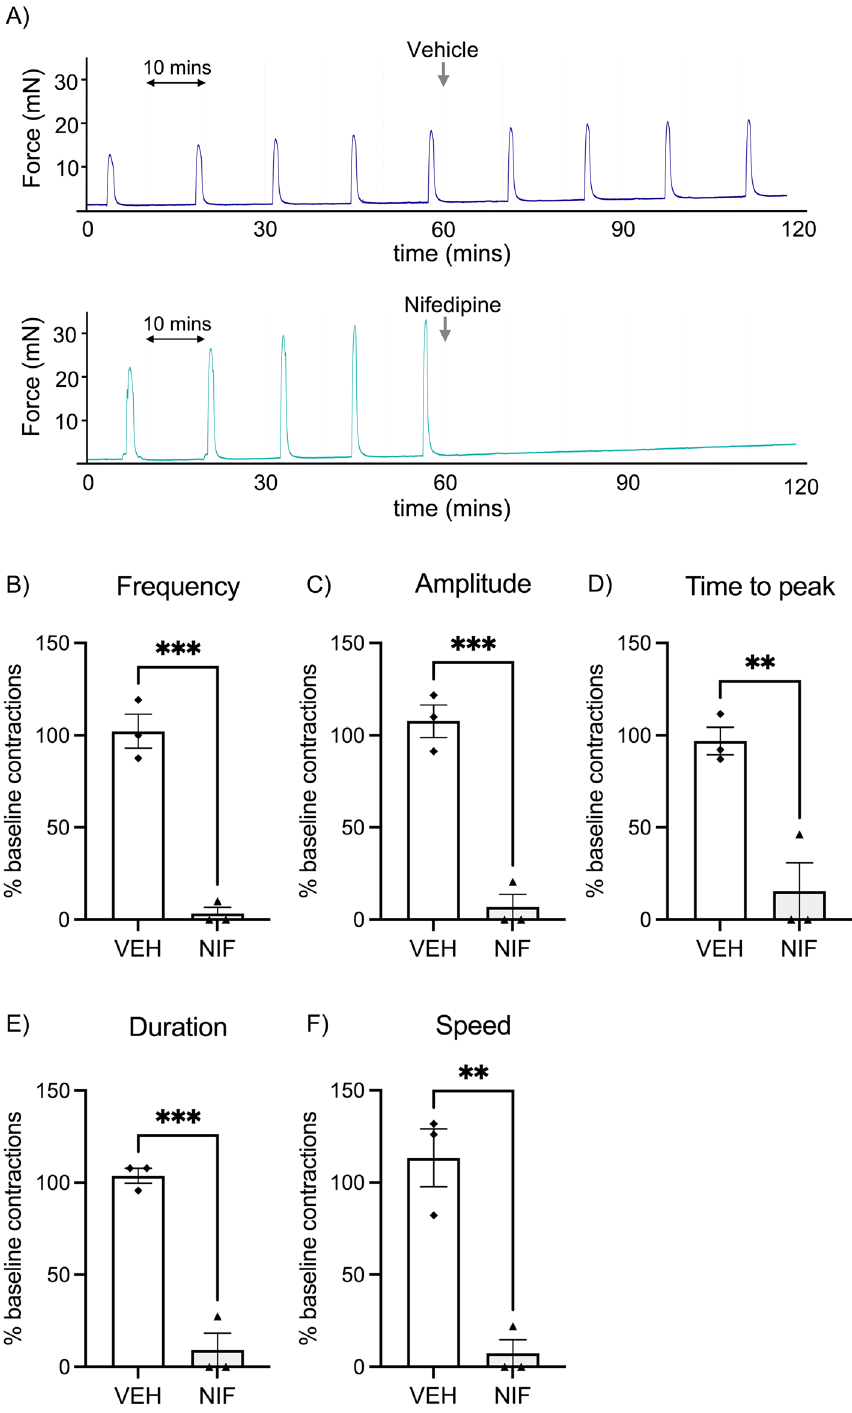
Figure 1. Myograph data showing anti-contractile effects of nifedipine (0.1 µM) on strips of human pregnant non-labouring myometrium ex vivo. ( A ) Representative trace in the upper panel showing that vehicle control (VEH) has no effect on established spontaneous contractions. In the lower panel, nifedipine (NIF) diminishes the established pre-treatment contractions. The y-axis is the measured force (millinewtons; mN). The entire initial 120 min equilibration period is not shown in these representative traces. ( B–F ) Nifedipine significantly reduces contraction frequency ( B ), amplitude ( C ), time to peak ( D ), contraction duration ( E ), and contraction speed ( F ) ( n = 3 patients). Data are presented as percentage of baseline (pre-treatment) contractility. Each point represents the mean of duplicates. Data were assessed for statistical differences using t tests. The error bars represent SEM, ** indicates P < 0.01, and *** indicates